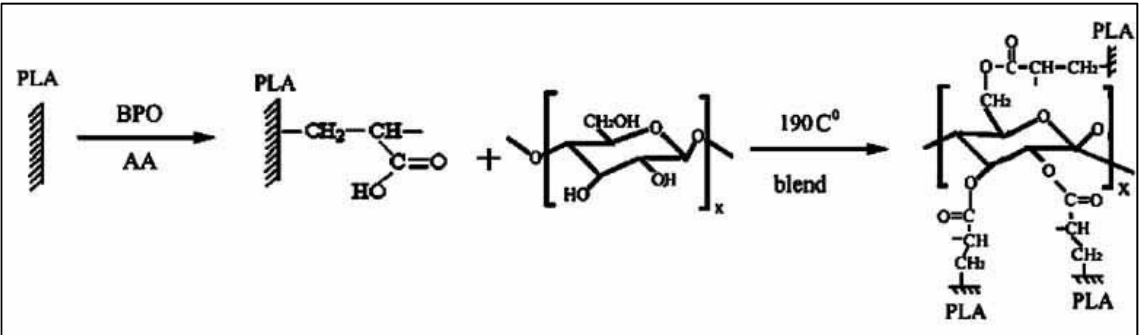
Figure 16. Reaction scheme for the grafting of acrylic acid on PLA and reaction with starch (from Wu, [82], copyright Wiley-VCH GmbH. Reproduced with permission).